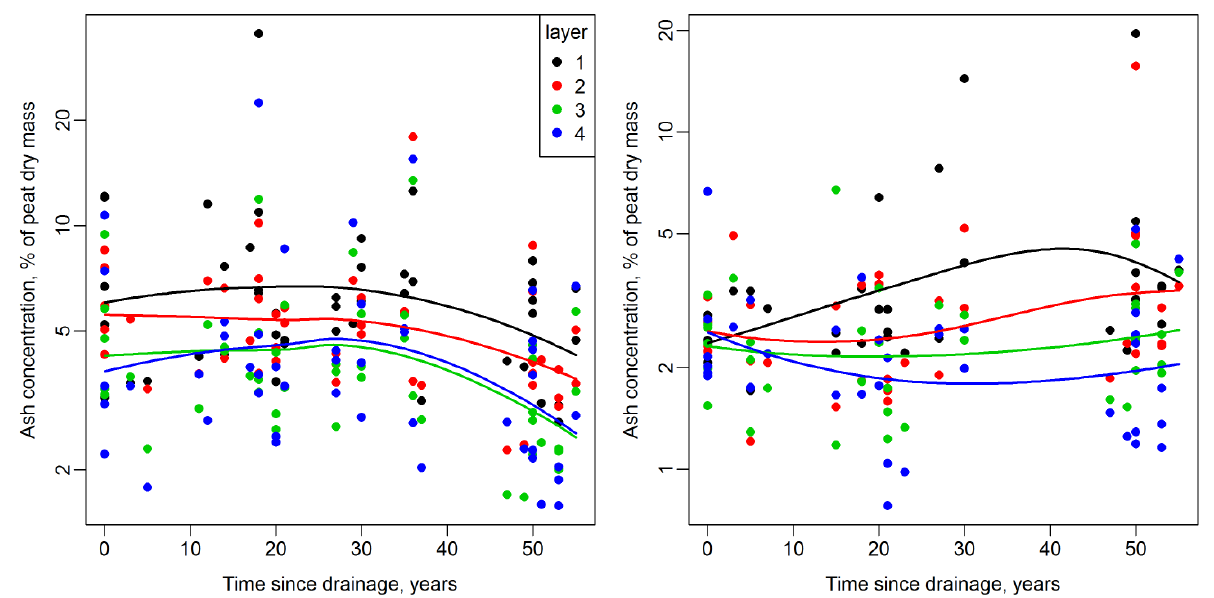
Figure A1. Ash concentrations (% of peat dry mass) as a function of time since drainage (years), in type groups 1 (left) and 2 (right); note the logarithmic scale of the y-axis. The lines show local polynomial regressions (Cleveland et al. 1992) fitted separately to the log-transformed ash concentrations of each layer. Fitting was carried out in the R environment (R Core Team 2015) using the loess function with smoothing parameter span =